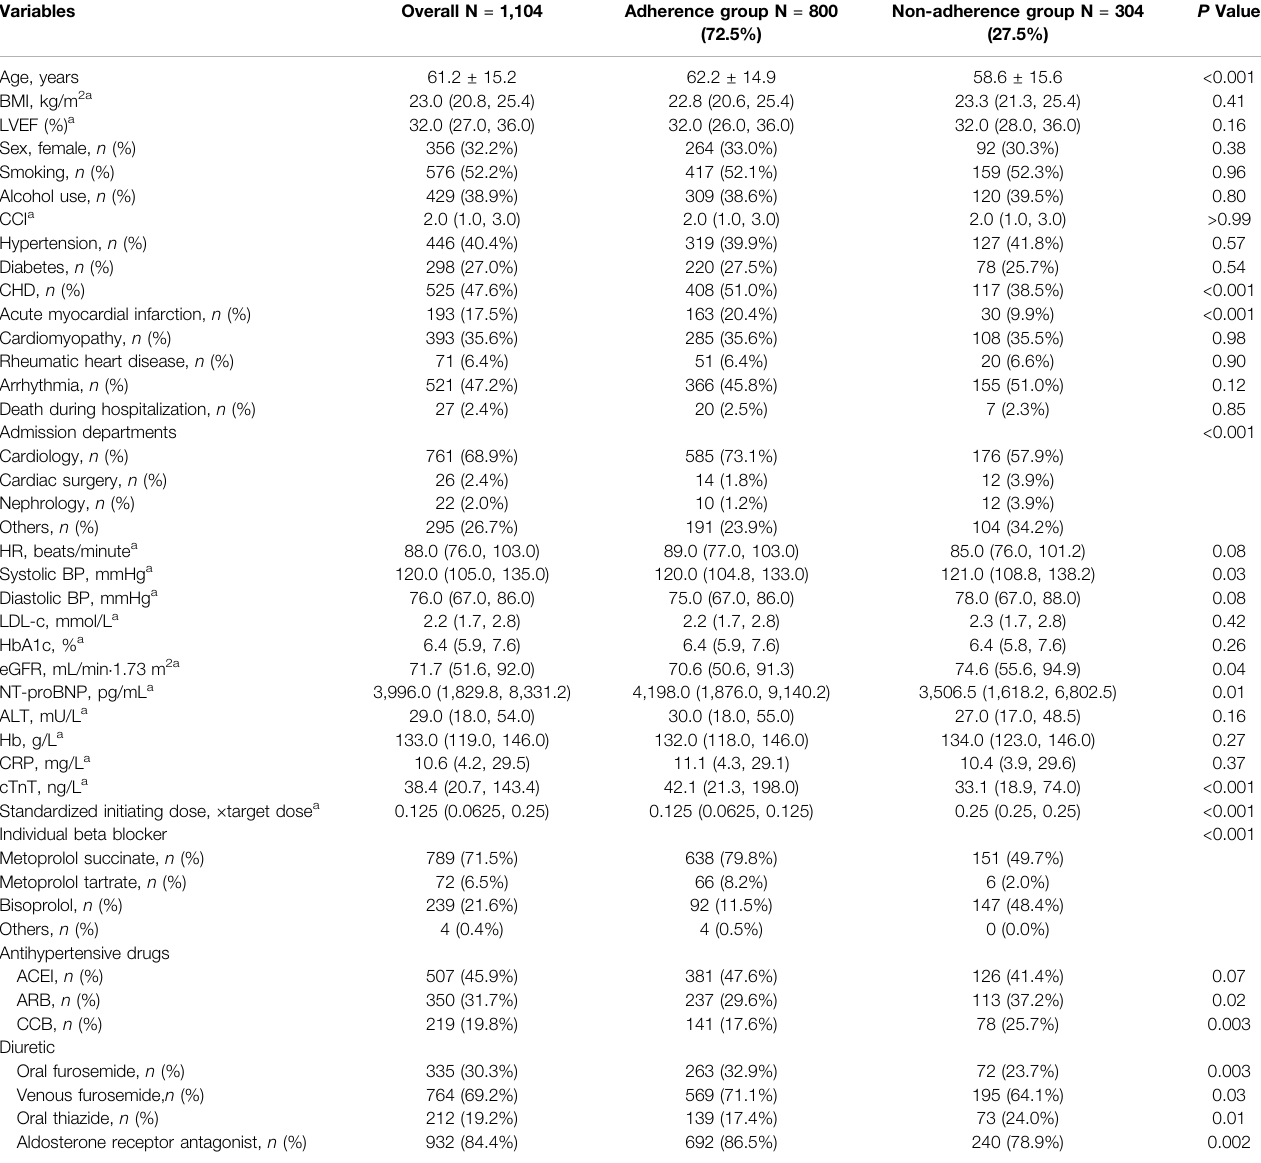
TABLE 1 | Baseline patient demographic and clinical